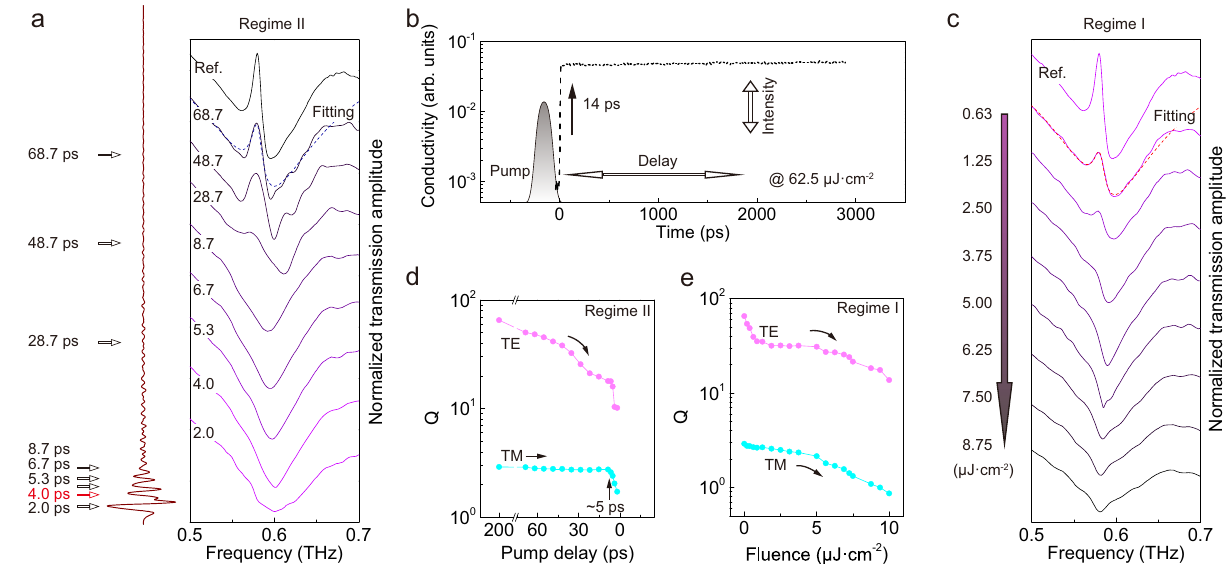
Fig. 3 Experimental veri fi cation of temporal loss boundary. a Spectra of perturbed cavity with injection of loss boundary at different temporal instants as indicated by the side inset. Dashed line shows the Lorentzian fi tting, and pump fl uence is fi xed at 62.5 μ J · cm − 2 . b Carrier dynamics of a pristine silicon fi lm measured by the variation of peak terahertz electric fi eld amplitude (proportional to conductivity) due to perturbation of the ultrashort pump pulse (not scaled) with width of 100 fs. The graph shows dynamics at a pump fl uence of 62.5 μ J · cm − 2 , and photocarriers reach the quasi-steady state within 14 ps which lasts for longer than 3 ns. c Spectra of the quasi-steady cavity at varied barrier heights in regime I, and dashed line shows the Lorentzian fi tting. Here, the pump is injected at t r « 0. Modulation of Q for TE and TM modes in the delay ( d ) and height ( e ) scenarios. Asynchronized modulation of TE and TM modes is observed in regime II while synchronized modulation occurs in regime